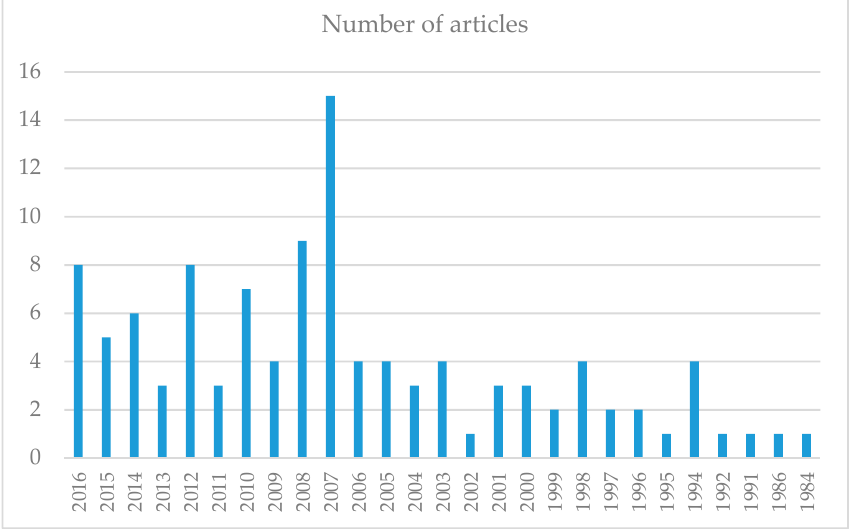
Figure 3. Respective years of publication of articles. Period: “AllYears”. Source: Research Data.